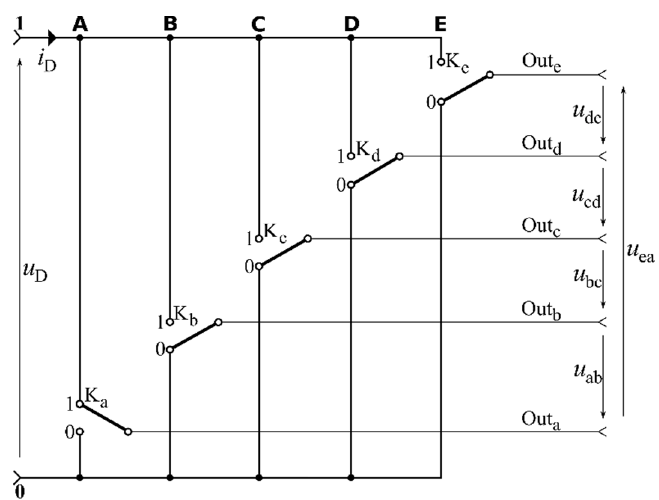
Figure 1. The model of the five-phase two-level inverter with five switches.